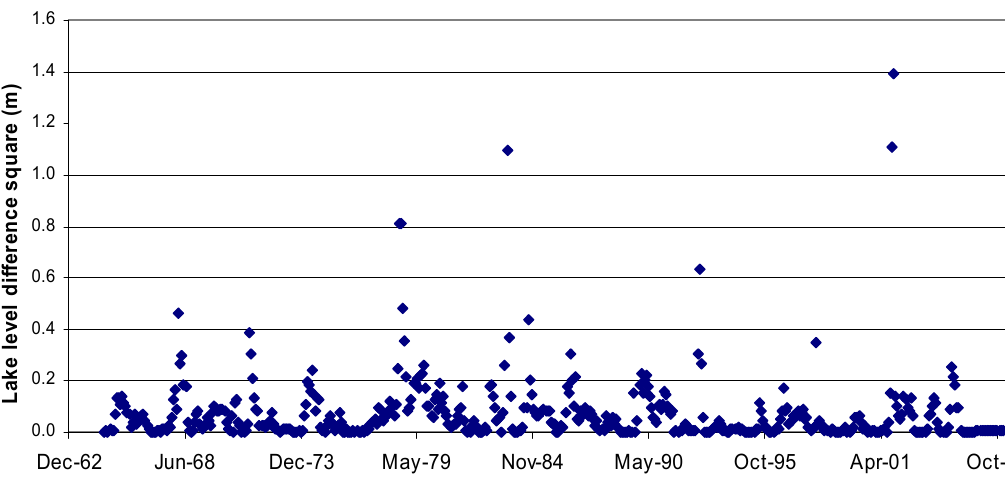
Figure 13. Temporal distribution of square difference between observed and calculated lake levels. Table 1. Average long-term (1964–2007) monthly contribution (in percent) of each Lake Linlithgow water budget component to the overall lake water